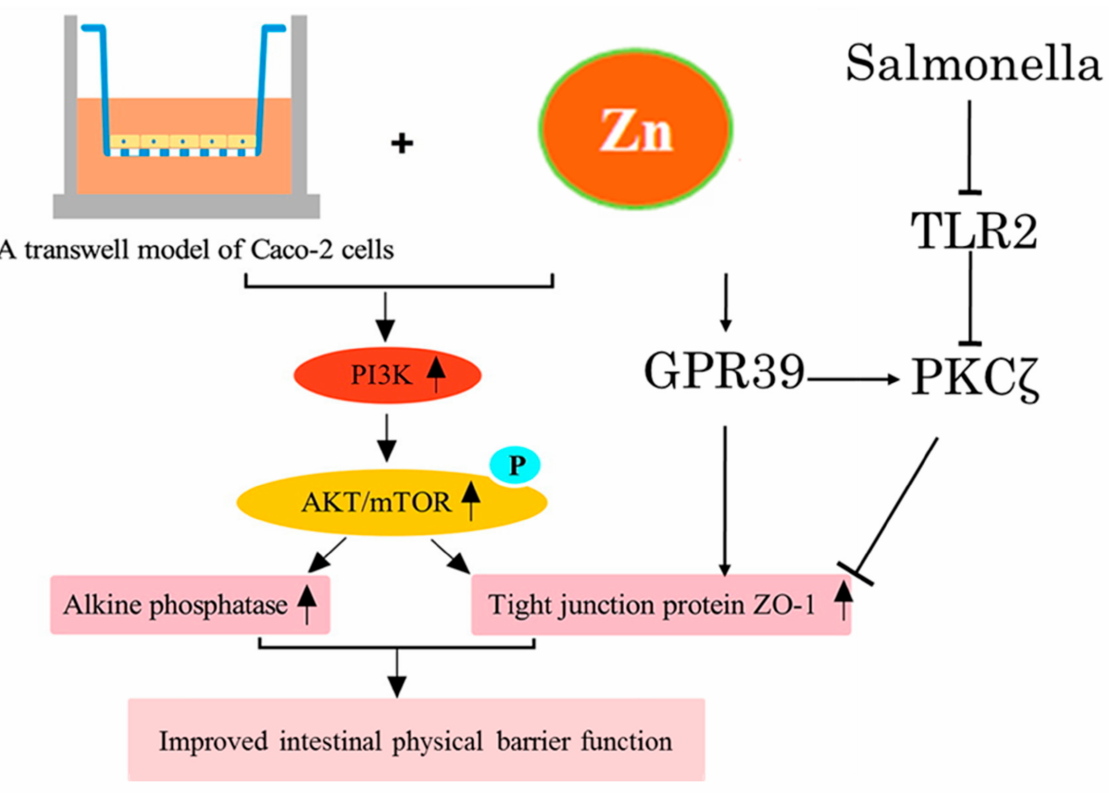
Figure 2. Cellular pathways in which zinc upregulates the function of the mucosal physical barrier. Zinc improves the expression of the tight junction protein by activating PI3K/AKT/mTOR. Zinc directly regulates the epithelial barrier via the G protein-coupled receptor (GPR39). Then,